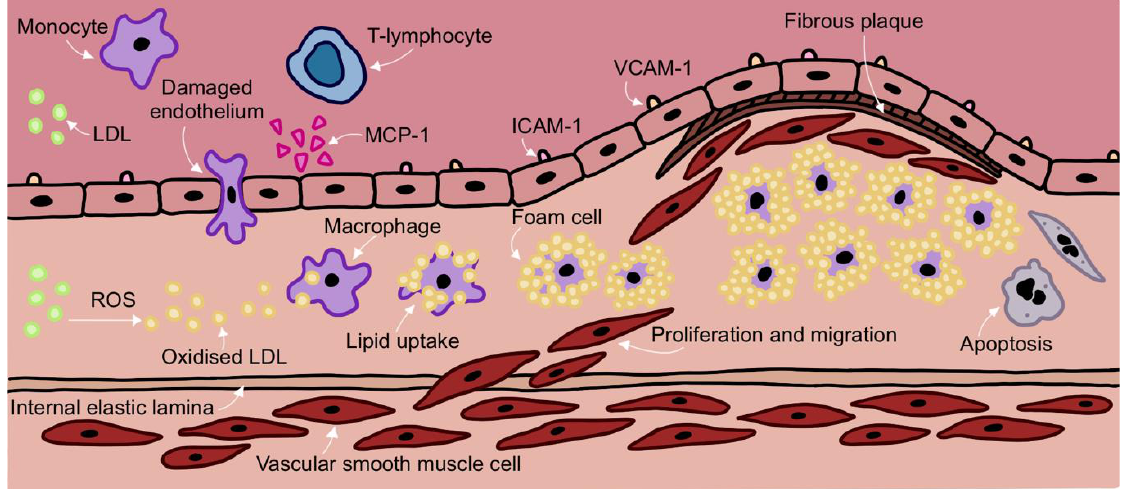
Figure 1. Overview of the Development of Atherosclerosis.